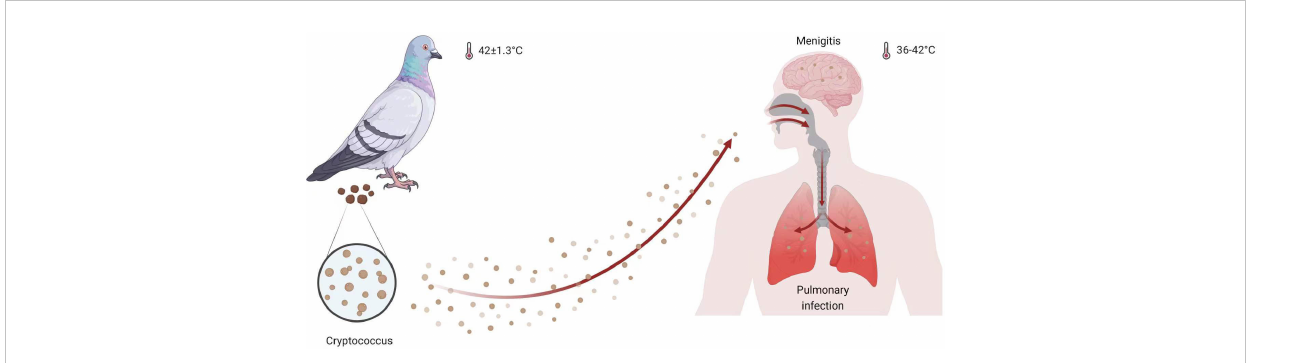
FIGURE 1 Cryptococcus infection model. Both humans and pigeons are hosts for Cryptococcus species, which specutilize thermotolerance to survive in pigeons with a body temperature of 42 ± 1.3°C and in humans with a temperature range of 36 to 42°C (Cramer et al., 2022). This fi gure was created with